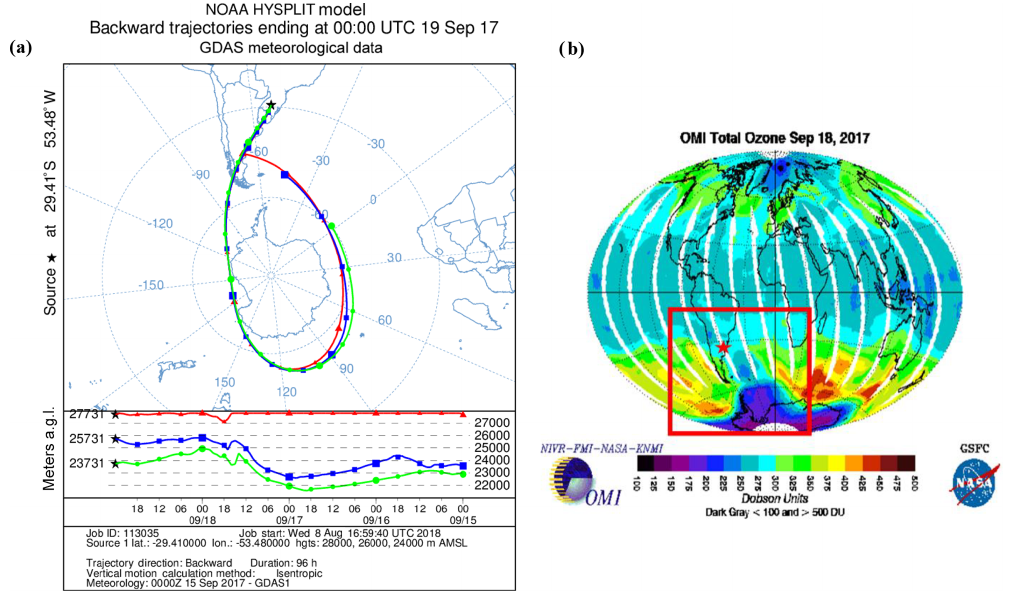
Figure 2. (a) Retroactive trajectories as retrieved by the Lagrangian HYSPLIT model, initialized on 19 September 2017 00:00UTC at the SSO location. The back-trajectories were run at 20km (in red), 24km (in blue), and 28km (in green) above ground level; (b) global TOC distribution as recorded by the OMI experiment on 18 September 2017. The red box focuses on the low-ozone event and the star symbol indicates the location of the SSO